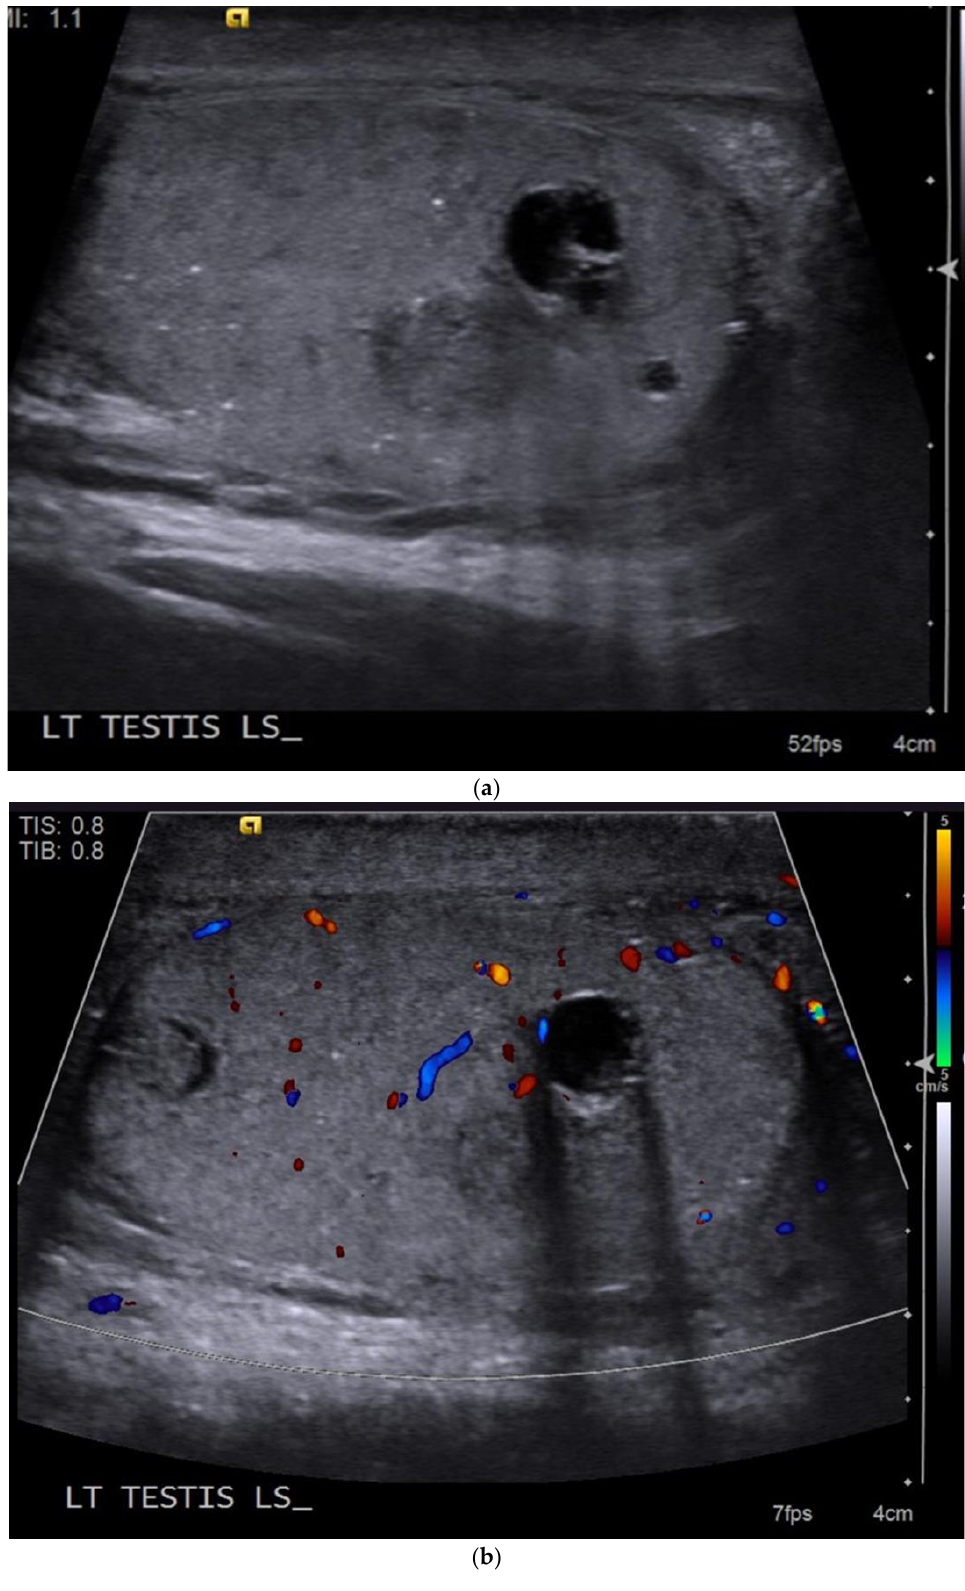
Figure 3. ( a ) B-mode ultrasound demonstrates well-defined intratesticular cystic and solid lesions with associated areas of calcification and additional microlithiasis. ( b ) Colour Doppler shows in- creased vascularity in the periphery of the tumour but not in the cystic